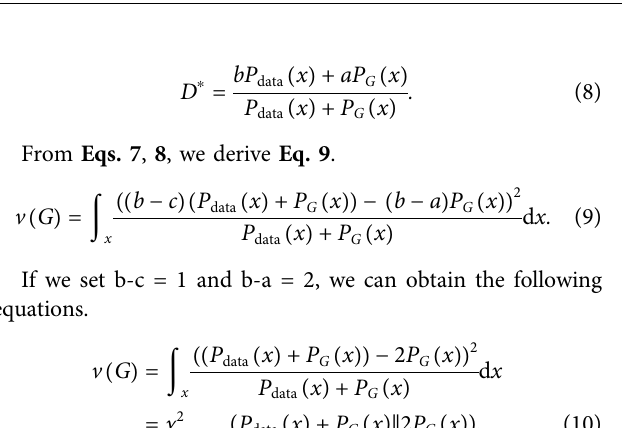
FIGURE 2 | Schematic diagram of the missing active power data in different